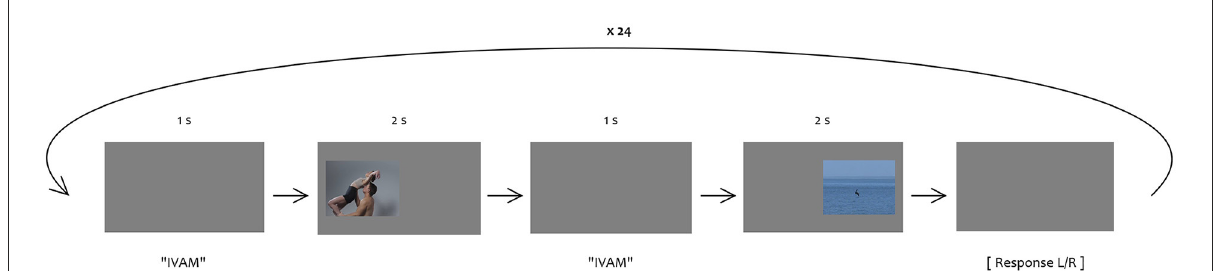
FIGURE1 Estimated means and 95% confidence intervals of selection congruency related to factors f 0 direction (left) and pitch discrimination accuracy (right) from analysis of the main experiment.